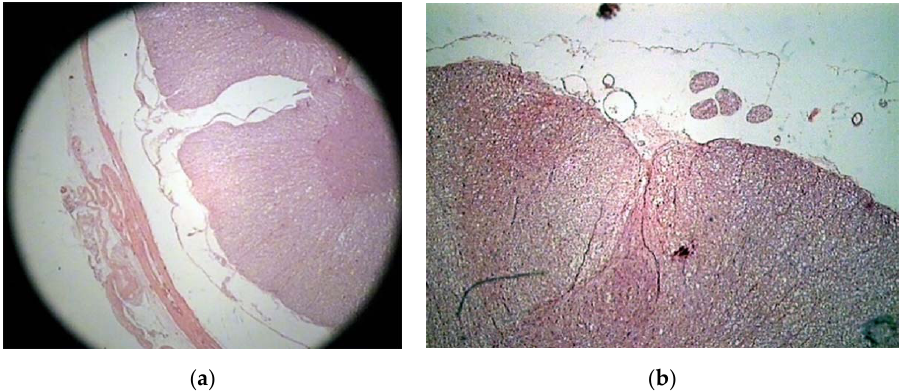
Figure 2. Histologic study executed on a dog’s bone specimen. Hematoxylin–eosin 2.5X ( a ) and 10X ( b ), showing the presence of live osteocytes and osteoblasts near the osteotomized surface (arrowheads).